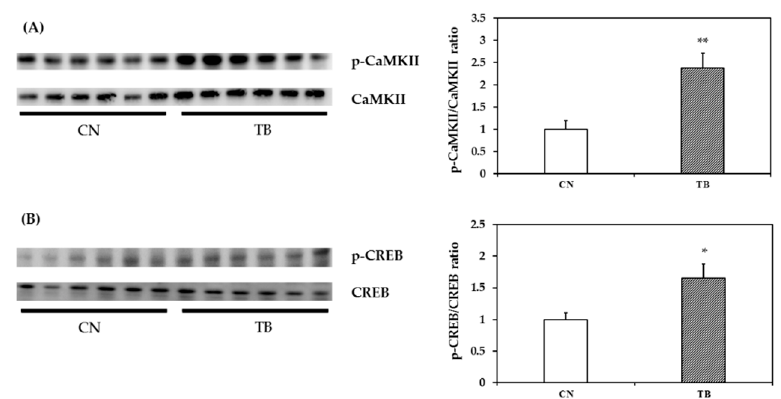
Figure 7. Phospho-CaMKII (p-CaMKII) and phospho-CREB (p-CREB) levels in the medial prefrontal cortex (mPFC) of control rats (CN rats) and theobromine (TB)-fed rats (TB rats). TB enhanced ( A ) p-CaMKII; and ( B ) p-CREB levels in the mPFC. Values are the mean ± S.E.M. ( n = 6 per group). * p < 0.05, ** p < 0.01; significant difference between groups.